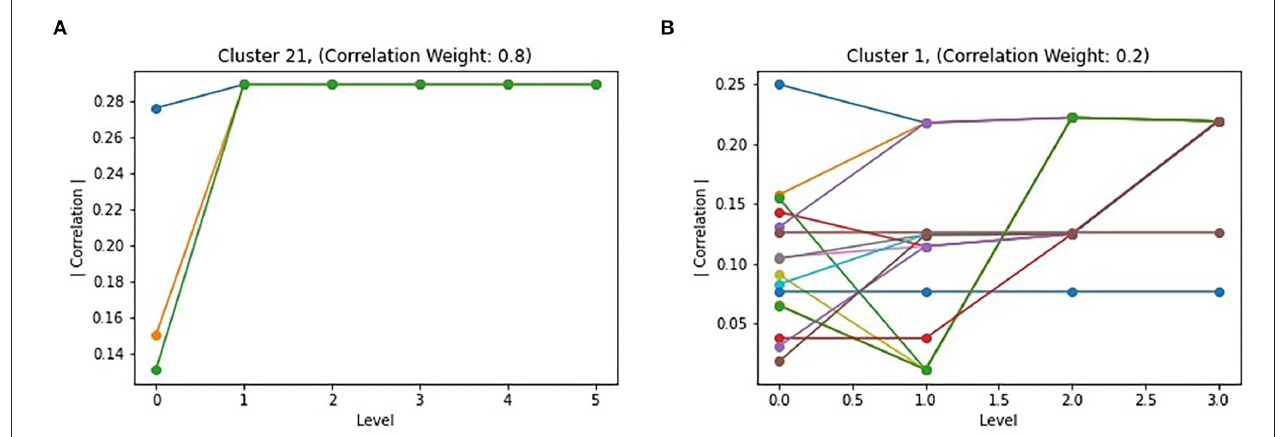
FIGURE 5 | Level effect of Correlated Louvain: (A) shows the intermediate clustering of cluster 21 with k 4 = 0.8, representing the common behavior of intermediate clusters; (B) shows uncommon behavior or intermediate clusters, such as cluster 1 with k 4 = 0.2.